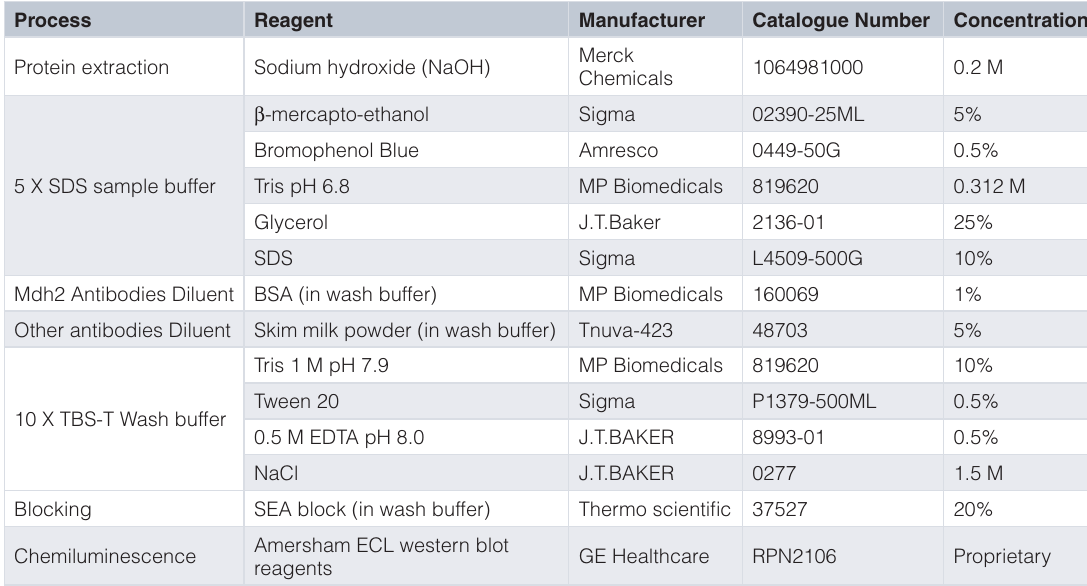
Table 3. Details of reagents for Western Blot.